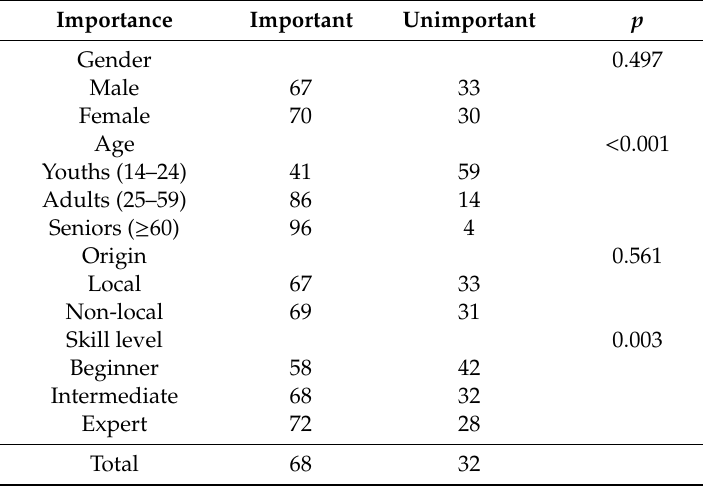
Table 4. Perceived importance of